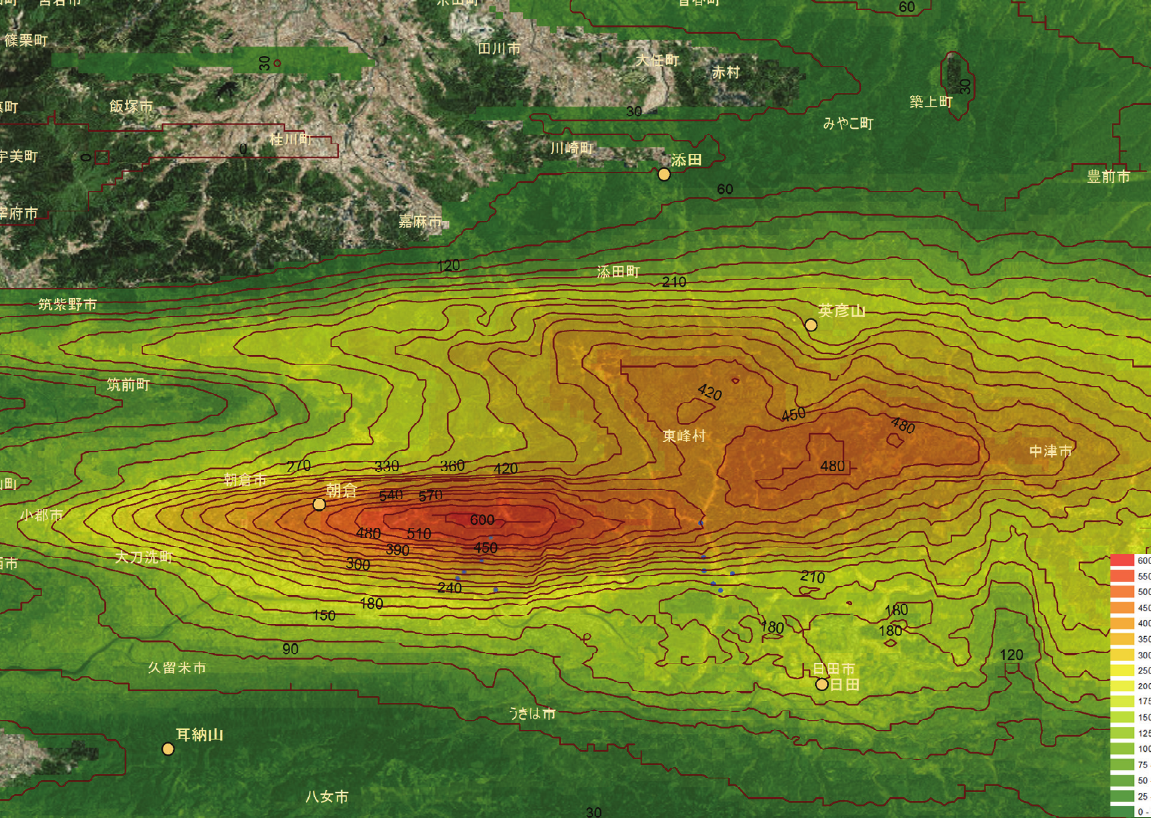
Figure 20 Amount of accumulated rainfall measured by the X-band MP radar (2017 1:00–24:00, July